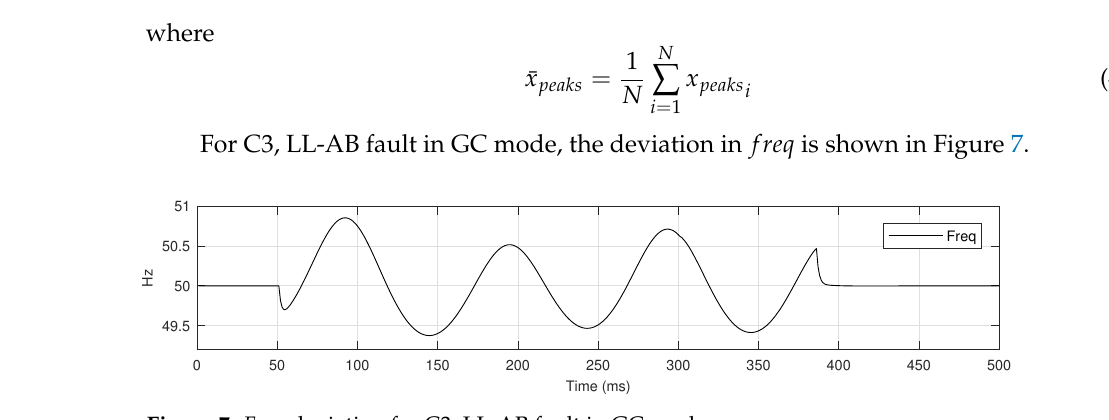
Figure 7. Freq deviation for C3, LL-AB fault in GC mode. For the above observation, there are four peaks with values 50.8540, 50.5164, 50.7120 and 50.4684. The ¯ x peaks is 50.6377, while ¯ x is 50.0130. For the above case, the value of PM is 1.0125. The difference in PM of Freq for LL-AB fault and NF conditions is shown in Figure 8.